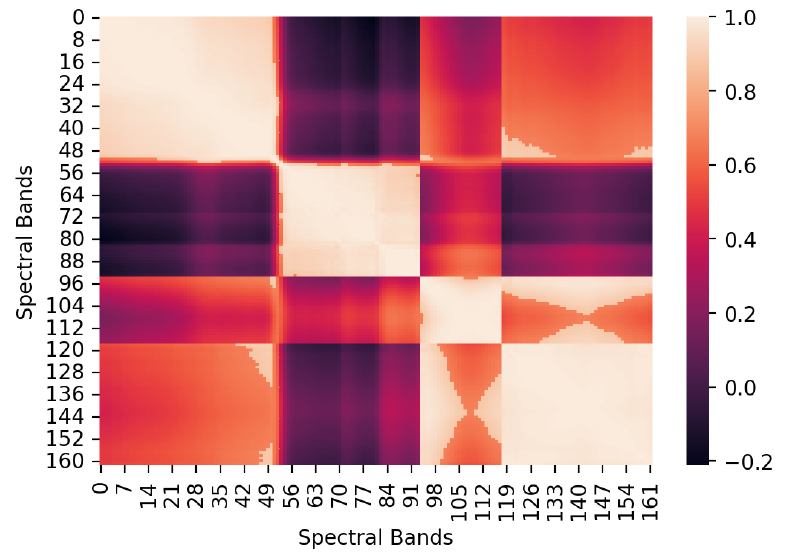
Figure 2. Heatmap of the correlation matrix of the spectral bands of the Urban